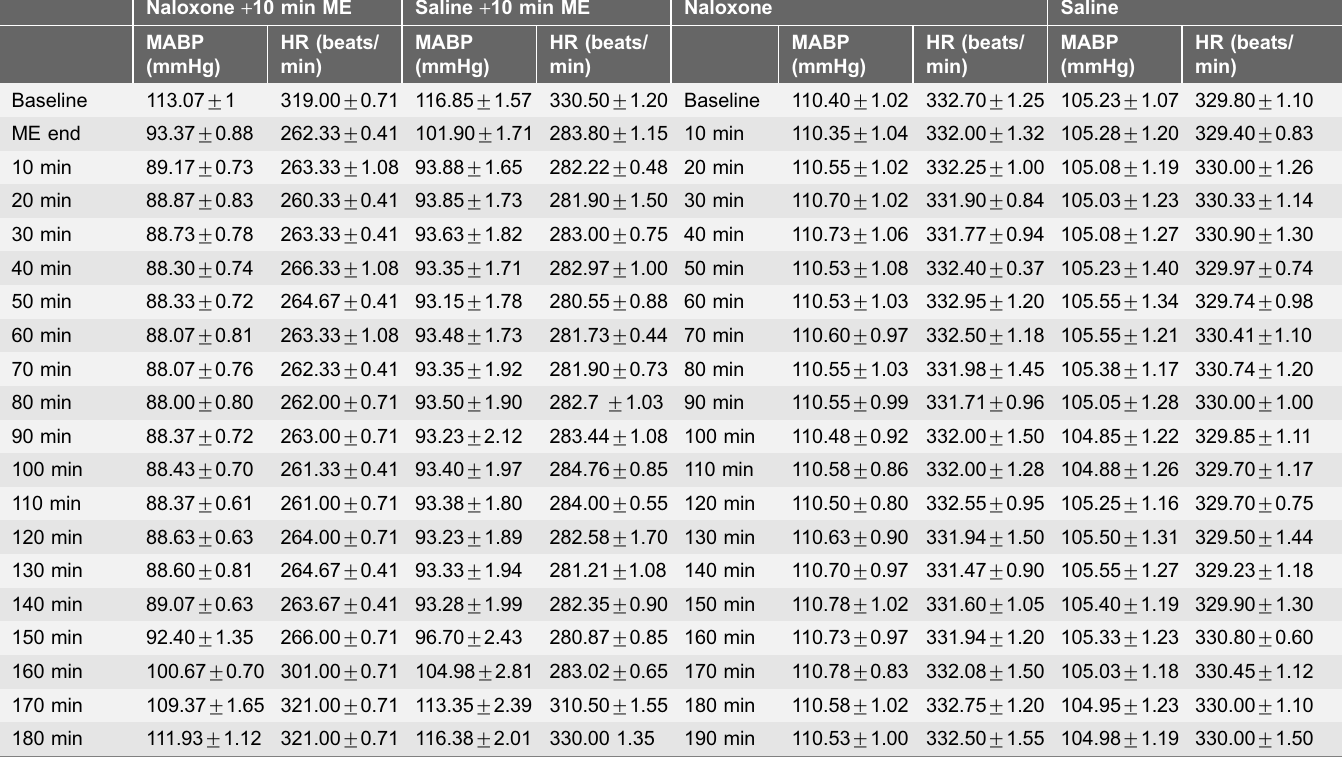
Table 2. Effects of intravenous administration of naloxone or saline on MABP and HR.